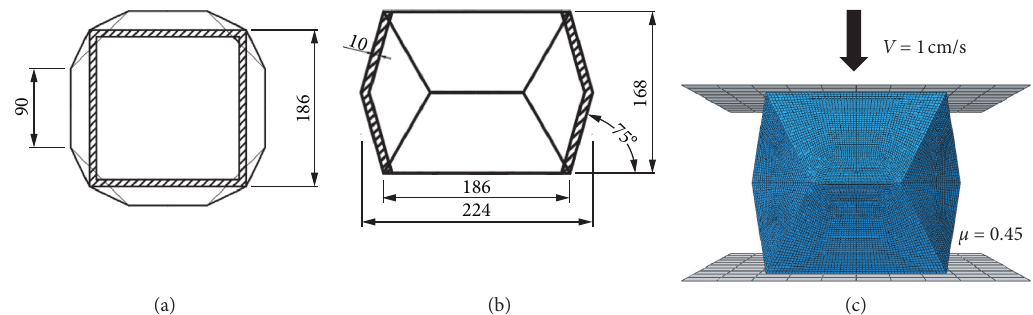
Figure 3: Dimension model of the energy absorption device: (a) main view of the device; (b) main view of the device; and (c) numerical model of the device.